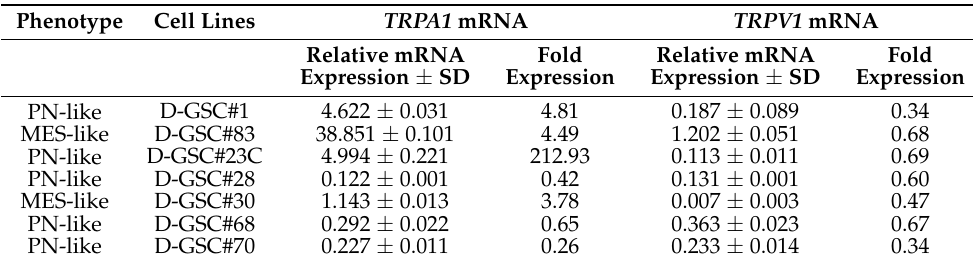
Table 4. TRPA1 and TRPV1 channels mRNA expression in